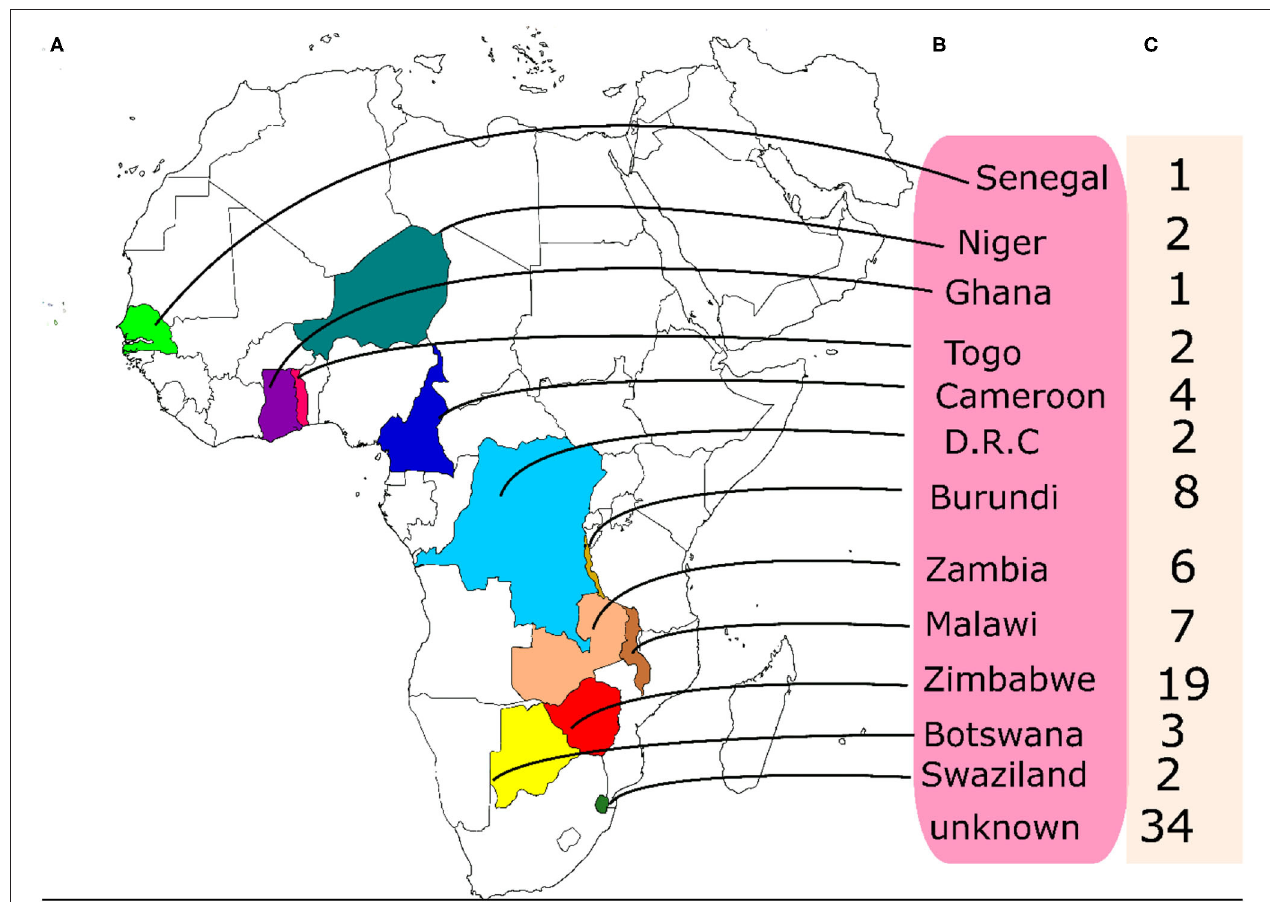
FIGURE 1 | Origin and numbers of accessions from each origin used in this study. (A) the locations of the origin of the accessions on the map, (B) the names of the countries of origin (C) the number of accessions from each